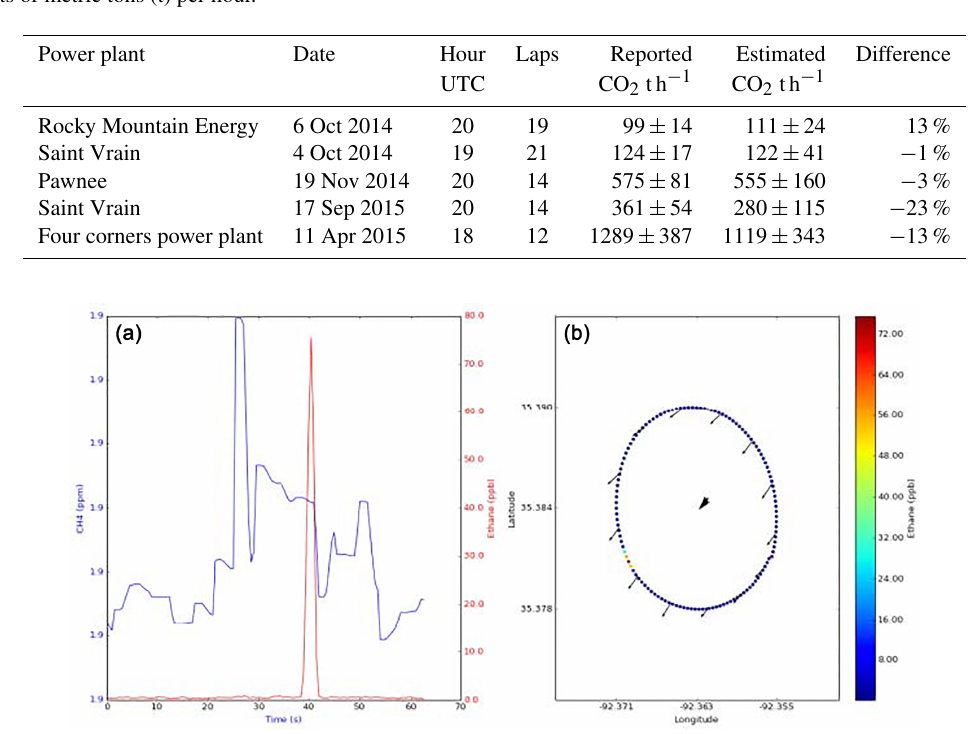
Table 4. Power plant estimates. The mid-point of the measurements (Hour UTC) is indicated in the third column (Hour). The reported emissions from the hour before to the hour after that time were averaged to derive the “Reported” emissions in column 5. Emissions are reported in units of metric tons (t) per hour.